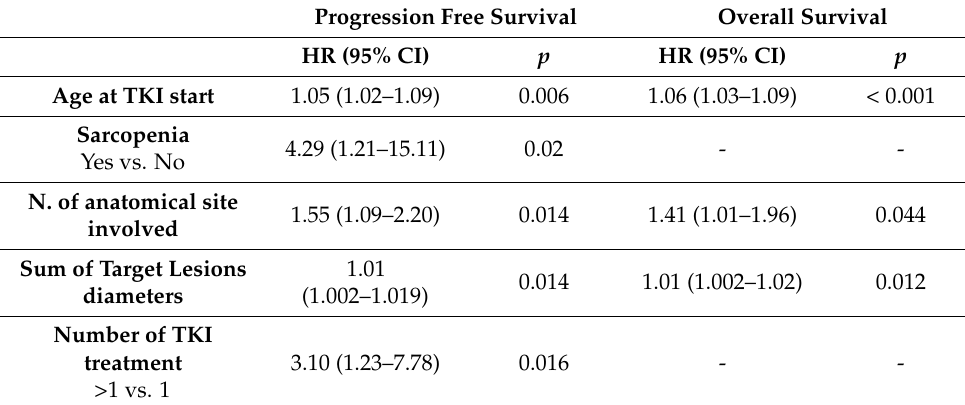
Table 2. Stepwise Cox regression for PFS and OS.